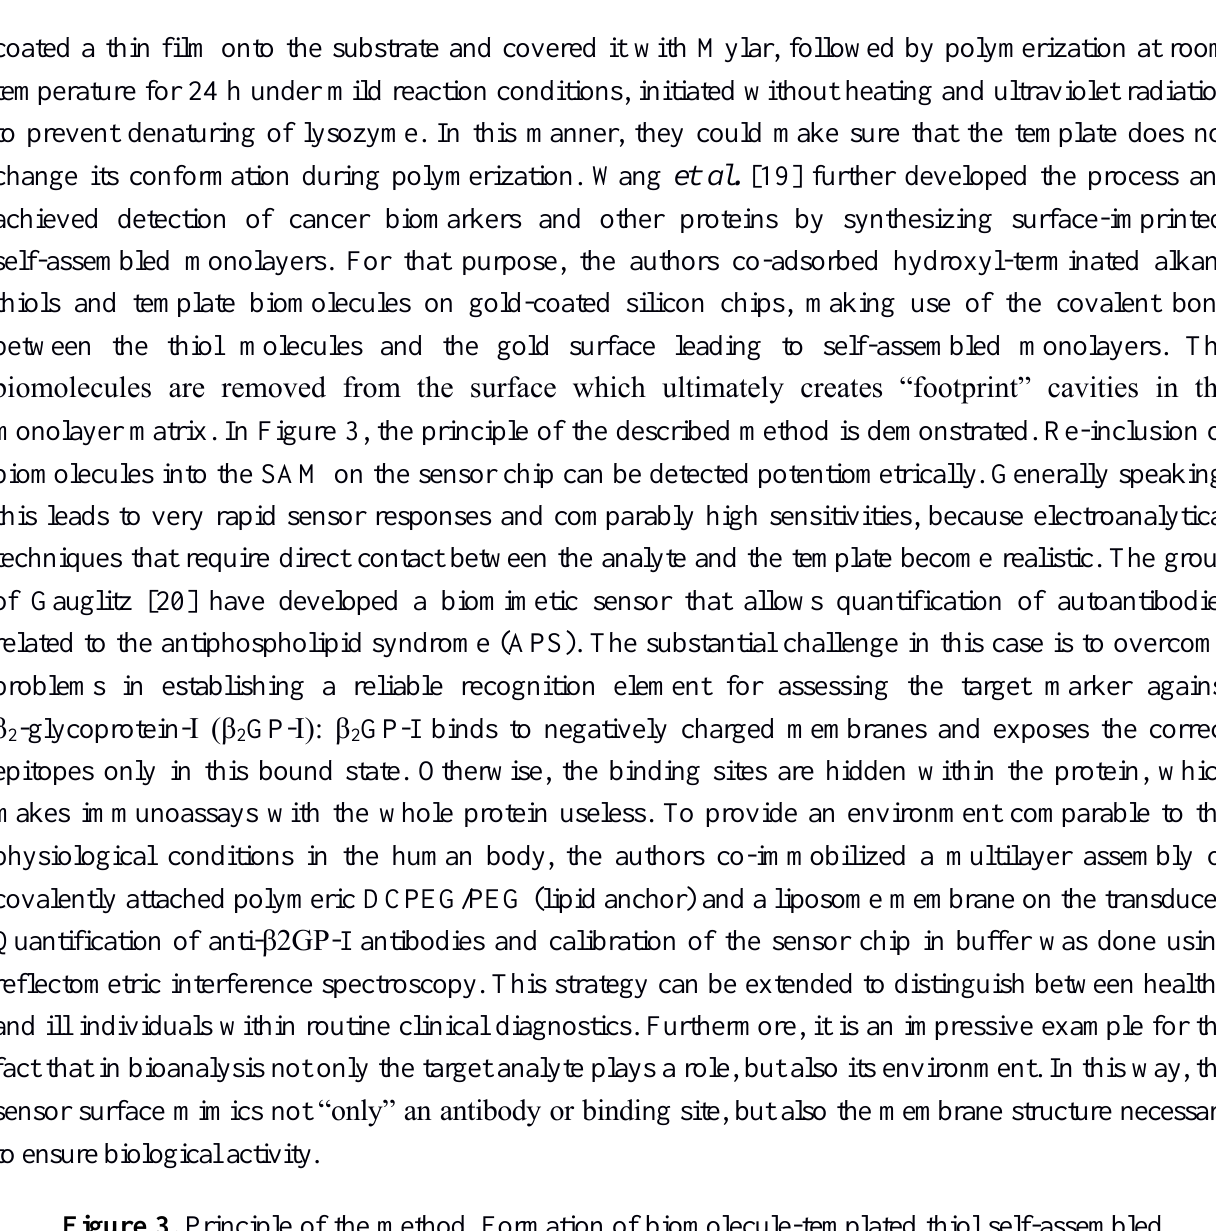
Figure 3. Principle of the method. Formation of biomolecule-templated thiol self-assembled monolayers (SAM), and the subsequent removal of the template molecules to create recognition sites in the SAM matrix. Reprinted with permission from [19], © 2010